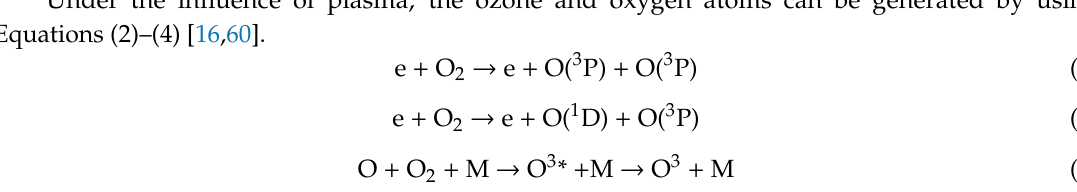
Figure S1: The dielectric barrier discharge (DBD) plasma reactor and infrared (IR) image of DBD plasma, Figure S2: The schematic illustration for the preparation of TCN composites photocatalysts, Figure S3: Photocurrent tests of TCN50-D at di ff erent potentials, Figure S4: Nitrogen adsorption–desorption isotherms (a) and pore-size distribution curves (b) of g-C 3 N 4 , TiO 2 and TCN50 samples, Figure S5: Thermogravimetric analysis curves, Figure S6: The high-resolution XPS spectra C 1s and N 1s, Figure S7: The EPR spectra of TiO 2 -C and D samples, Figure S8: FTIR spectra, UV–vis DRS and XPS valence band (VB) spectra of TCNX, Figure S9: EDS patterns and element mapping of TCN50-D sample, Figure S10: Trapping experimental of photogenerated radicals and holes in TCN50-D sample for the RhB degradation, Figure S11: VB XPS of TiO 2 -C, TiO 2 -D, TCN50-C and TCN50-D, Table S1: Surface and structural characterization of TiO 2 , g-C 3 N 4 and TCNX